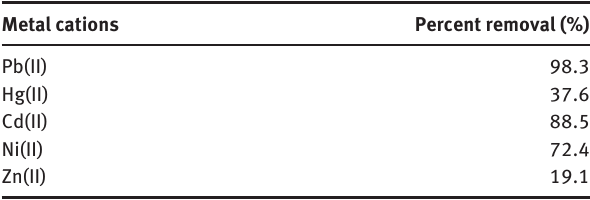
Adsorption conditions: Metal ion concentration, 400 mg/l; pH, 4;